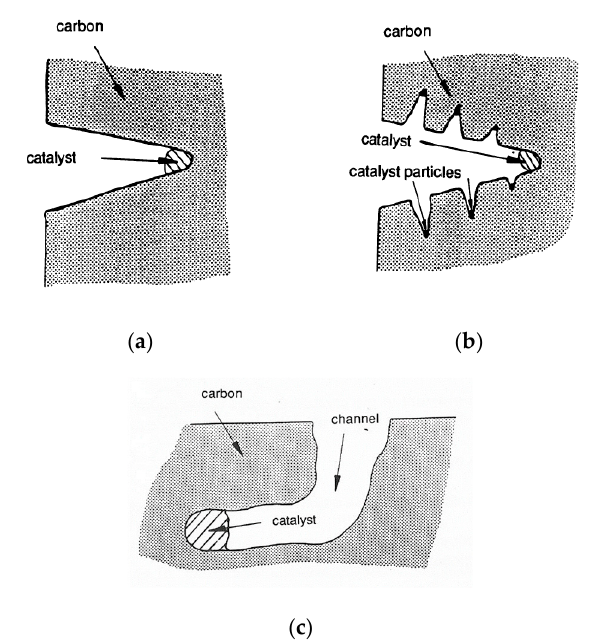
Figure 7. ( a , b ) Catalytic channeling action resulting in fluted channels. ( c ) Changing direction of a channeling catalyst particle.